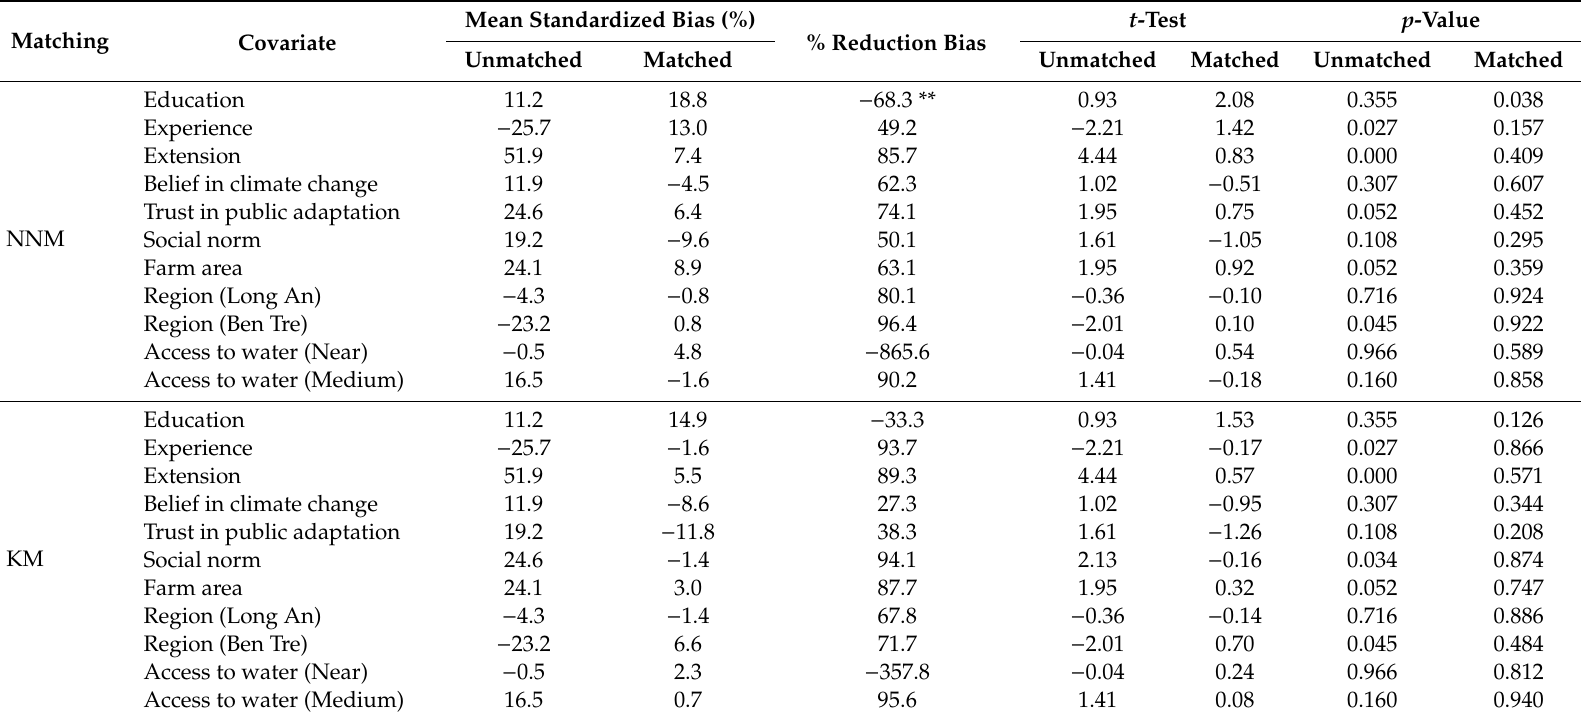
Table 11. Result of balance test of treatment variable of adaptation